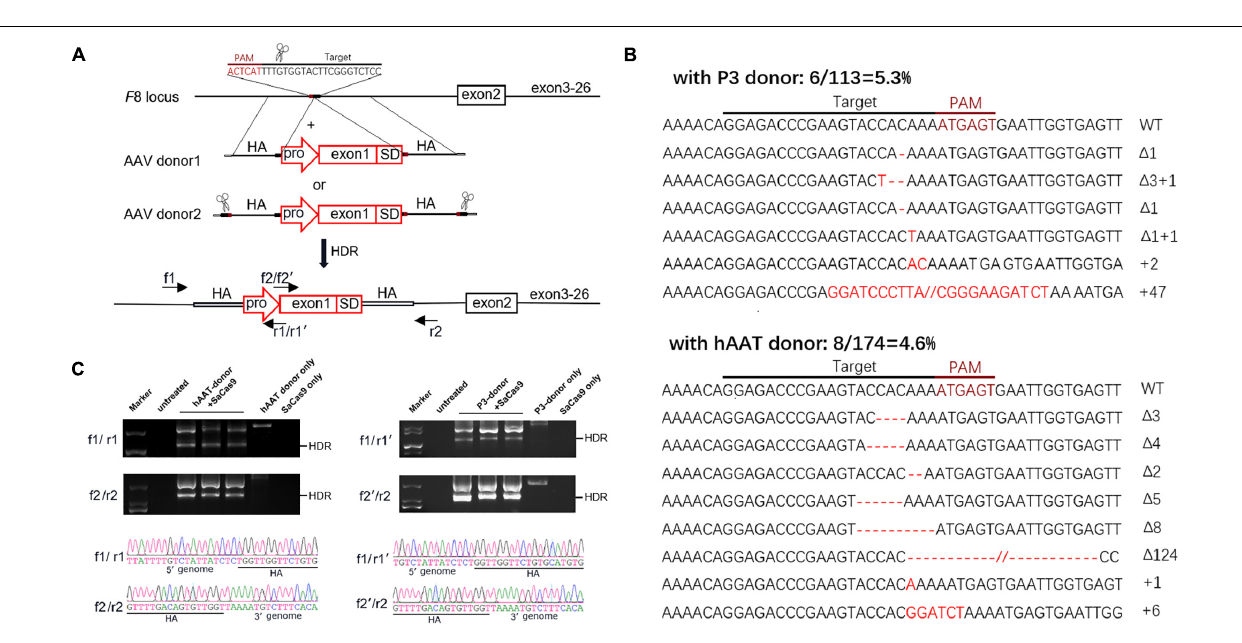
FIGURE 4 | Targeted repair of the truncated F8 in vivo . (A) Schematic representation of the repair strategy for the truncated F8 . HA, homologous arm; pro, promoter; SD, splice donor site. (B) Target sequences and the mutation induced by CRISPR/SaCas9. The wild-type (WT) target sequence is shown at the top with the intended target site of the sgRNA. Deletions are indicated by red dashes, and insertions by red capital letters. (C) PCR analysis for detection of the targeted integration. The expected product for HDR integration is indicated. The PCR products were confirmed by Sanger sequencing. Larger products corresponding to NHEJ integration were also sequenced (see Supplementary Figure 5